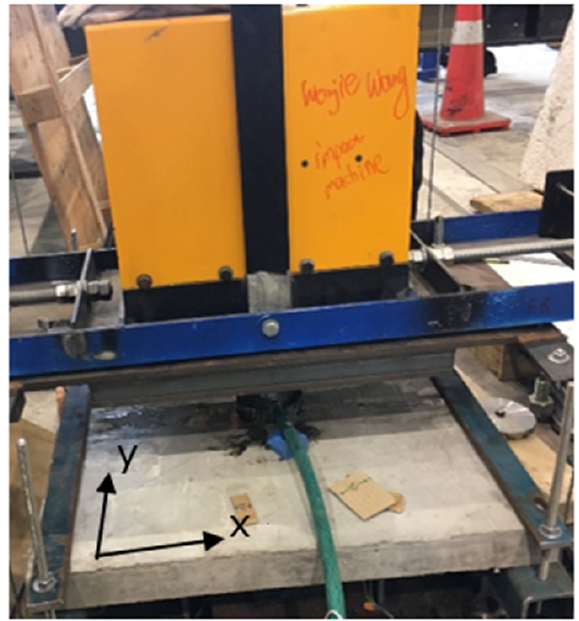
Figure 7. Test set-up for square specimen Group